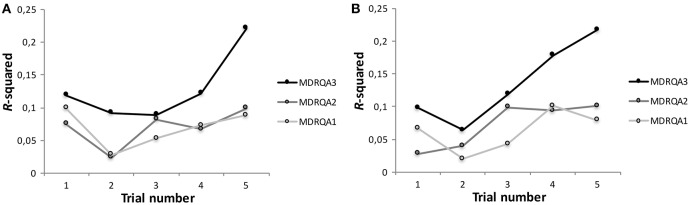
R2 of a simple regression model using RR, DET, ADL, and LDL as predictors for (A) the number of successfully built origami boats and (B) the number of unsuccessful attempts during each of the five trials for average individual dynamics (MdRQA1), average dyadic dynamics (MdRQA2), and group-level dynamics (MdRQA3). As all regression models had the same number of degrees of freedom (predictor DF = 4, residual DF = 95), a significant model at α = 0.05 had to explain at least 9.6% of variance (R2 = 0.096), i.e., all models with R2 > 0.096 are significant at p < 0.05.